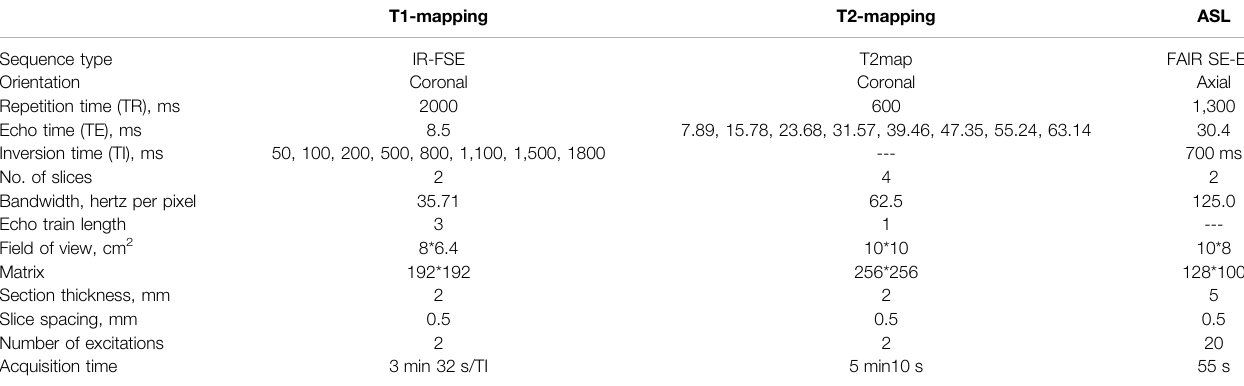
TABLE 1 | Scanning parameters for mpMRI sequences.